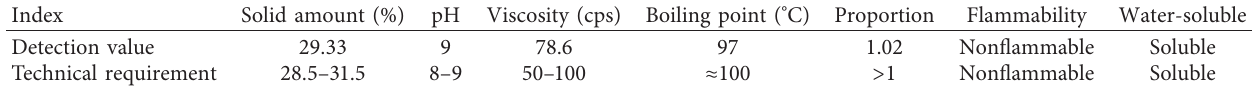
Table 1: Technical performances of the SRX stabilizer.